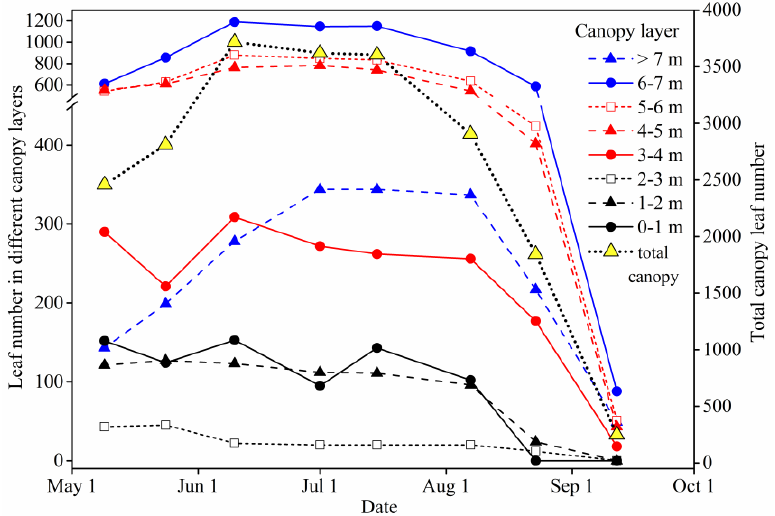
Figure 5. Variation of the leaf number in different canopy layers and of the total canopy.